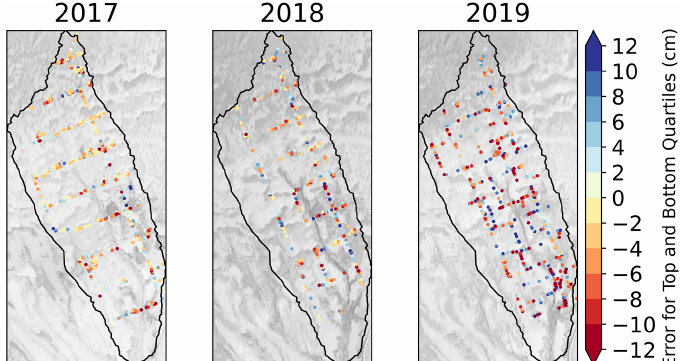
Figure A7. Spatial error (predicted minus observed) for the uppermost and lowermost quartiles of error in the random forest SWE prediction for